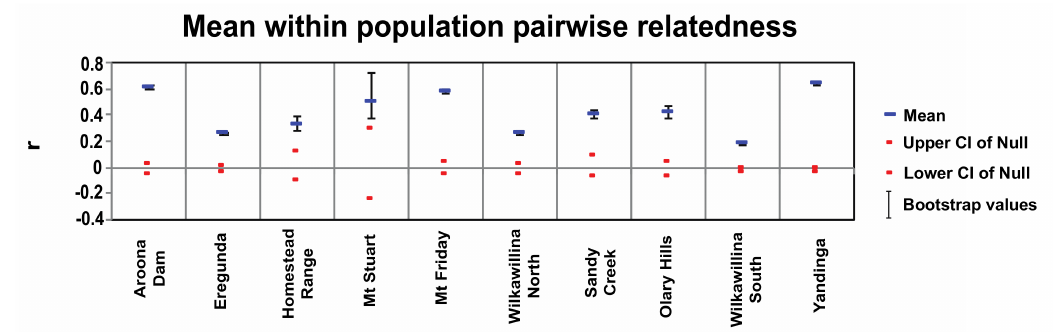
Figure 3. Within population mean pairwise relatedness (r) for P. x. xanthopus from 10 populations in South Australia. Calculations followed the method of [65] with the 95% upper and lower confidence bounds around the null hypothesis of no di ff erence across populations (red). Error bars surround the mean pairwise relatedness (r, blue line) based on 1000 bootstrap resampling.